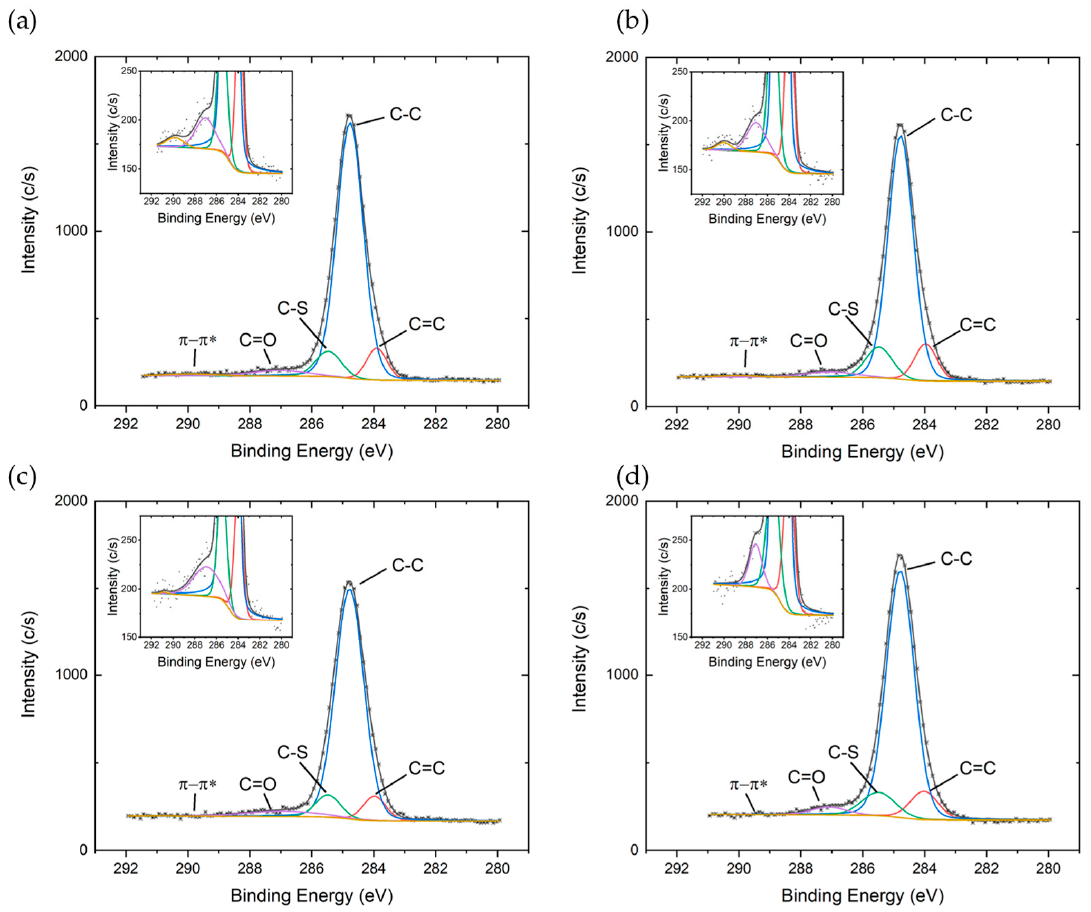
Figure 2. High resolution C1s spectra of P3HT deposited on Si / SiO 2 substrate ( a ) from toluene solution without adhesion promoter, ( b ) from toluene solution with Ti prime, ( c ) from oDCB solution without adhesion promoter, and ( d ) from oDCB solution with Ti prime. The insets show a zoom on the π − π ∗ shake-up satellite region.